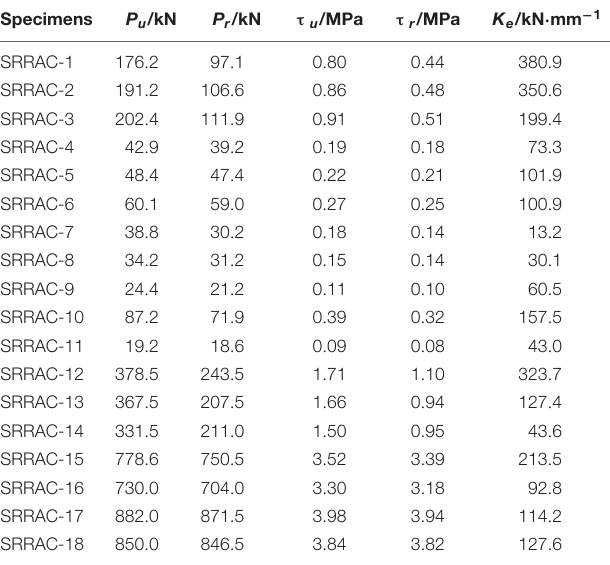
TABLE 4 | Bond properties of SRRAC after high temperature.